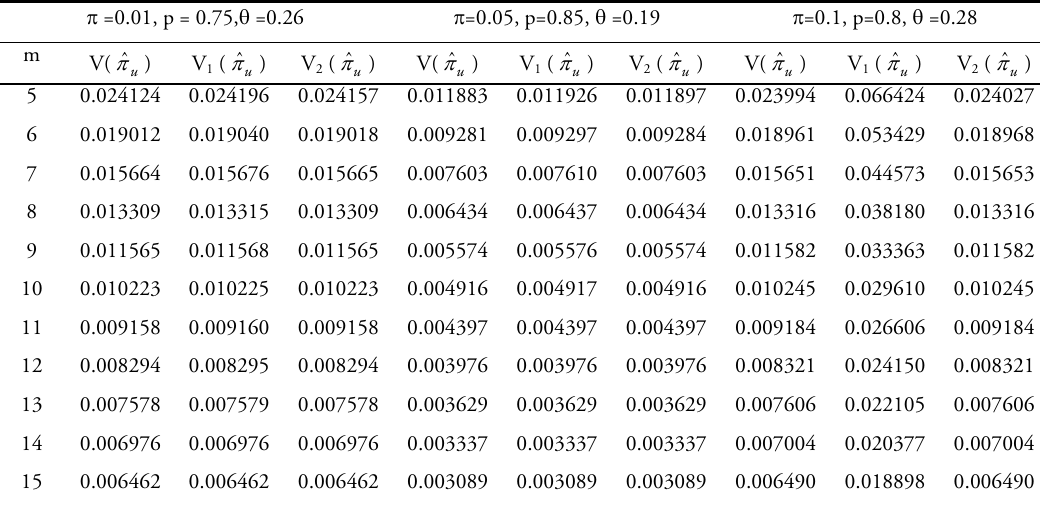
(cid:83) ˆ ) and its bounds V j ( u